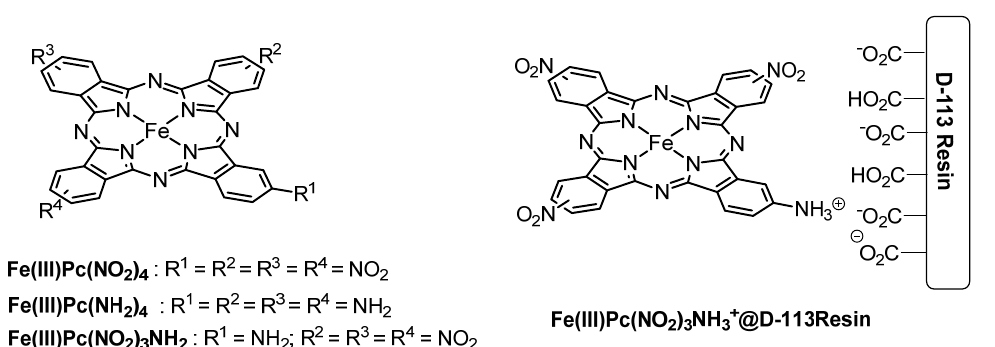
Figure 6. Molecular structure of the free Fe(III)Pc(NO 2 ) 4 , Fe(III)Pc(NH 2 ) 4 , Fe(III)Pc(NO 2 ) 3 NH 2 , and